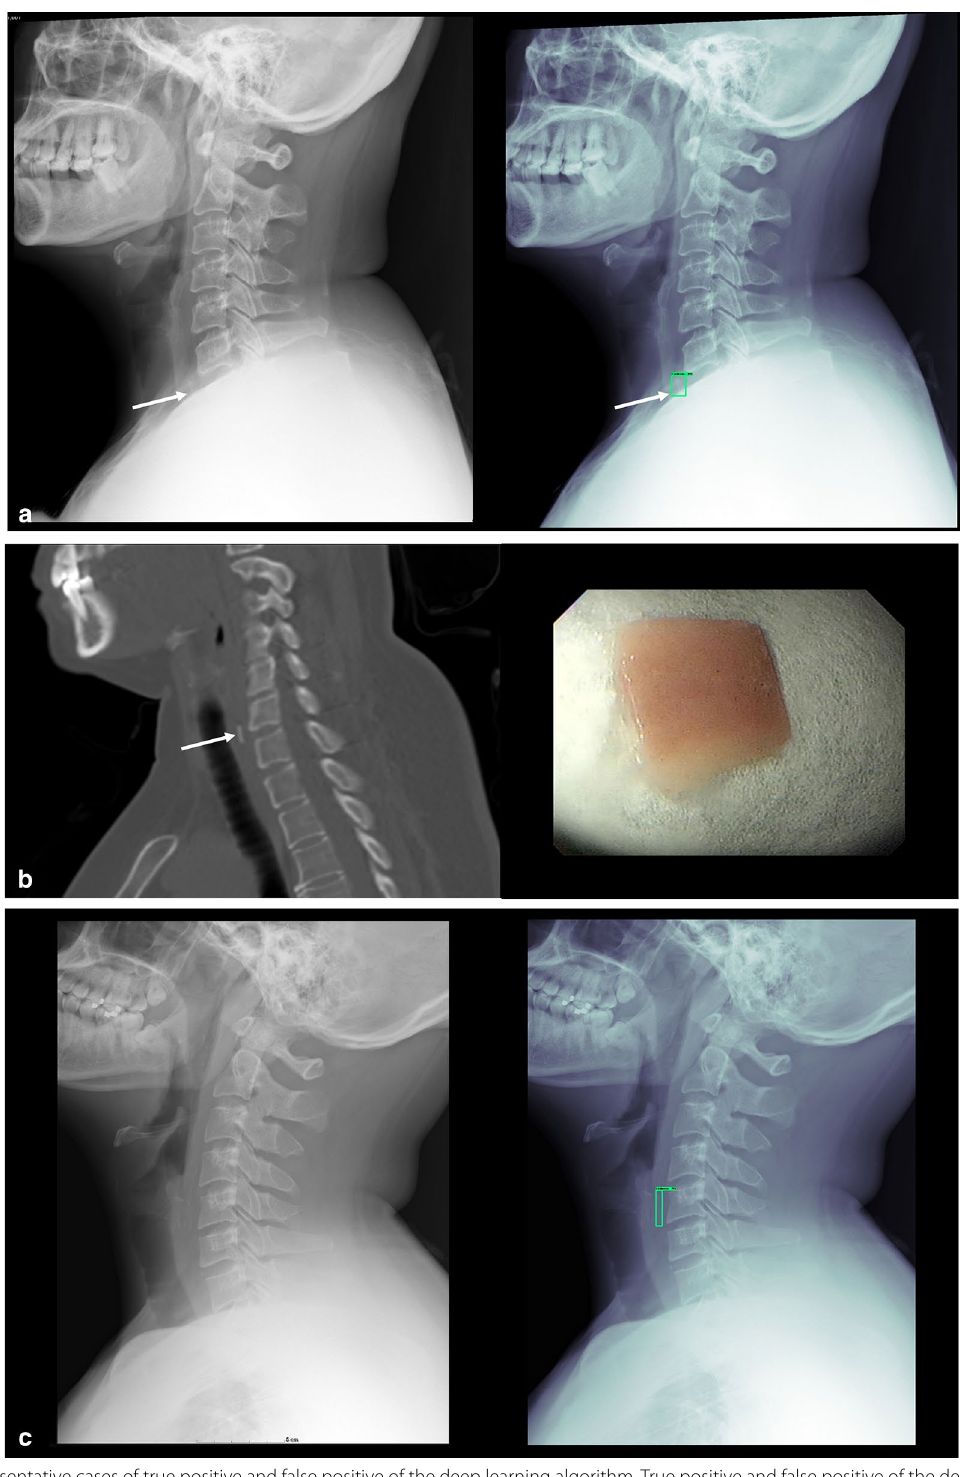
Fig. 2 Representative cases of true positive and false positive of the deep learning algorithm. True positive and false positive of the deep learning algorithm. a Plain radiograph of the lateral neck and the results of the deep learning algorithm showed a foreign body (arrows) over prevertebral soft tissue at C7 level partially obscured by the shoulder. b CT without contrast showed a foreign body over the cervical esophagus at C7 level and the photograph of the specimen retrieved revealed a flat rectangular shaped fish bone. c The deep learning algorithm misinterpreted the calcified postero‑inferior lamina of the thyroid cartilage as a foreign body. This can be confidently recognized by identifying the two parallel lines conforming to the shape of the bilateral postero‑inferior lamina of the thyroid